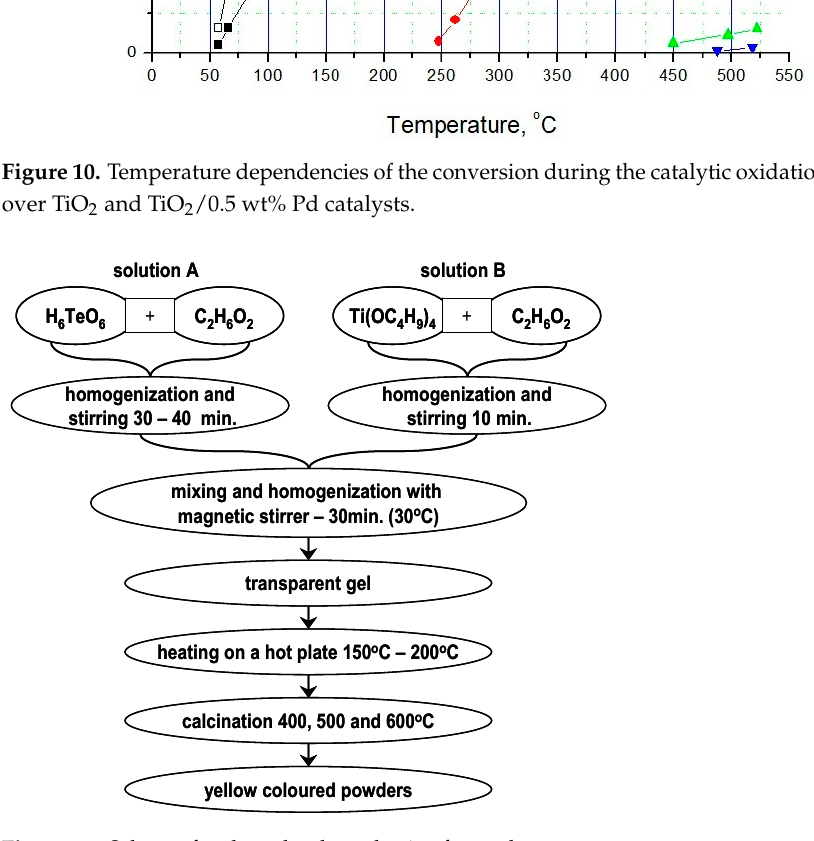
Figure 11. Scheme for the sol-gel synthesis of samples.